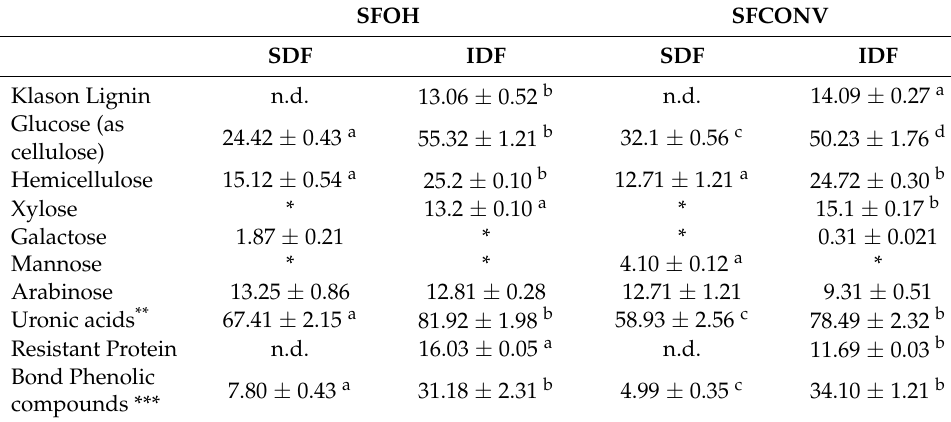
Table 2. Constituents (g/100 g fiber DW) of SDF and IDF from SFOH and SFCONV